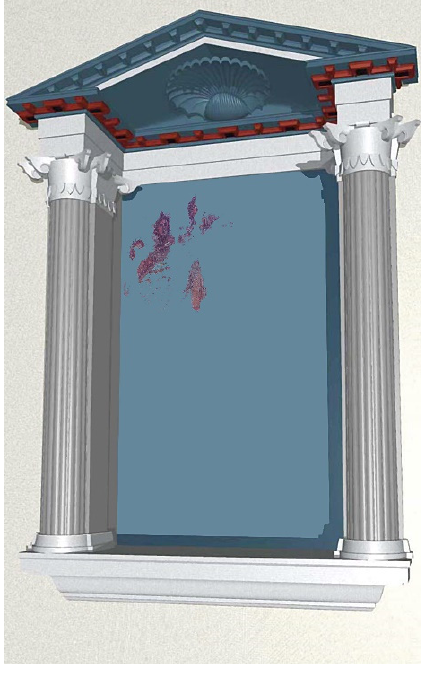
Figure 18. Reconstructed form of the aedicula from house H10 (processing Rafał Czerner).